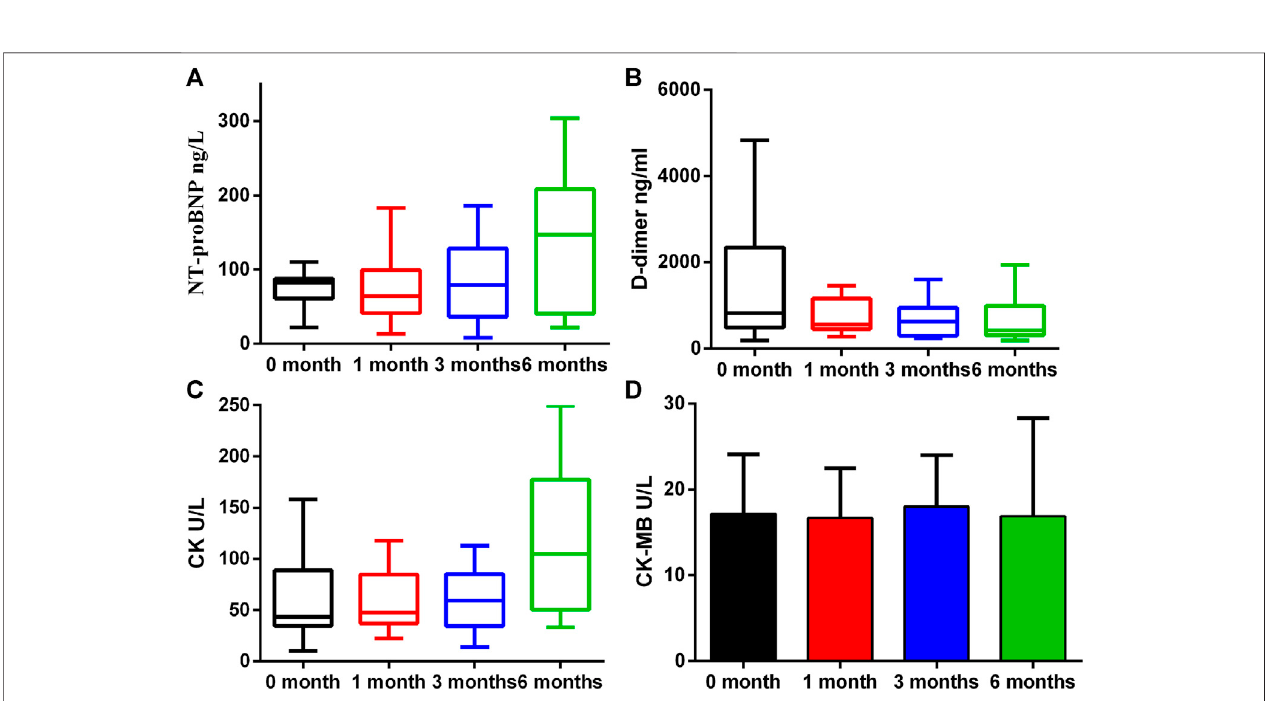
FIGURE3| PlasmaconcentrationchangesofH-FABP,GDF-15,Gal-3,andPTX3overICIstreatmenttime.Edgesofboxesdenote25thand75thpercentiles,lines are median concentrations, and error bars are minimum and maximum concentrations. (A) H-FABP: heart type-fatty acid binding protein; (B) GDF-15: growth differentiation factor 15; (C) Gal-3: galectin 3; (D) PTX3: pentraxin-related protein 3.